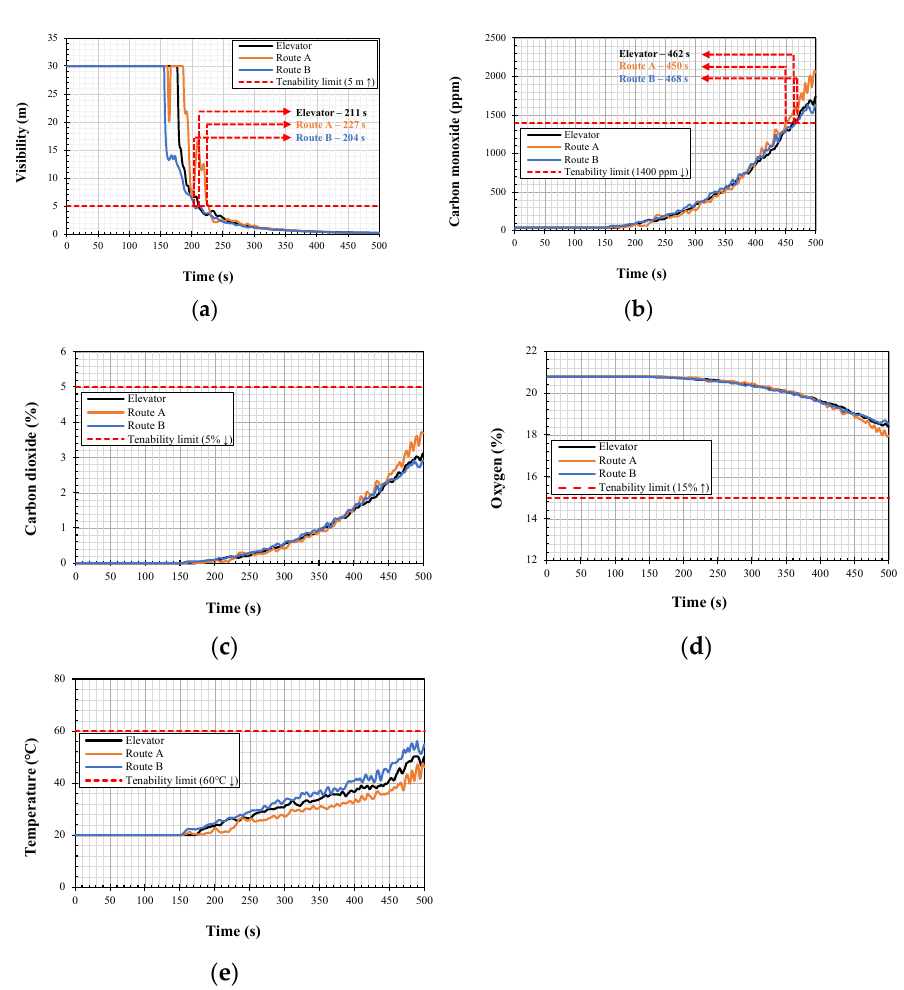
Figure 7. ( a ) visibility; ( b ) carbon monoxide; ( c ) carbon dioxide; ( d ) oxygen; ( e ) temperature.